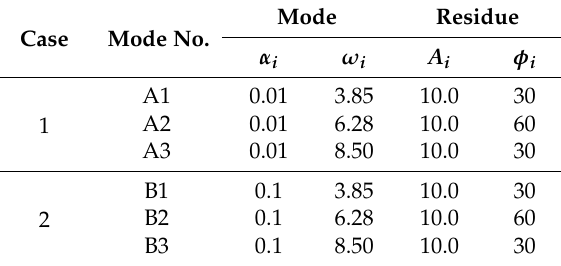
Table 1. The exact parameters.